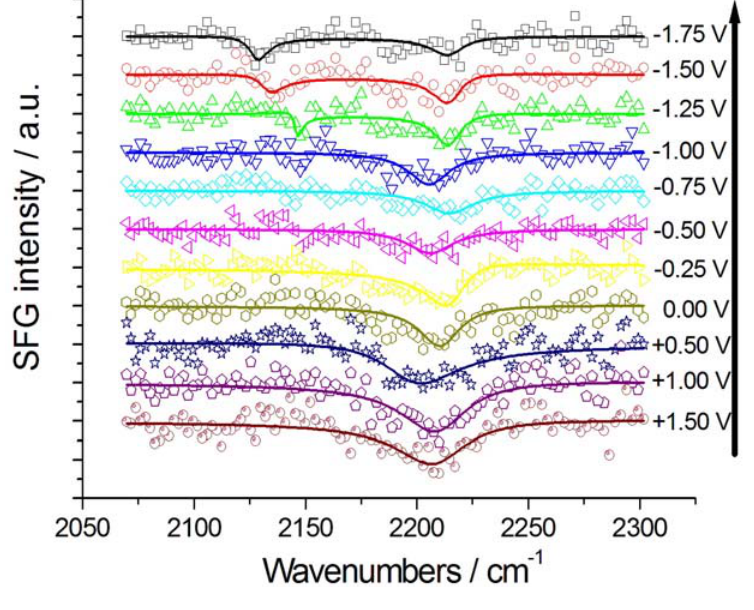
Figure 2. Potential-dependent SFG spectra of Au in contact with [BMP][TFSA] containing 1 mM CTDB and the corresponding fits: Cathodic-going scan (from +1.50 V to − 1.75 V, starting with pristine Au electrode). The potential scan sequence (cathodic-going scan) is indicated by the